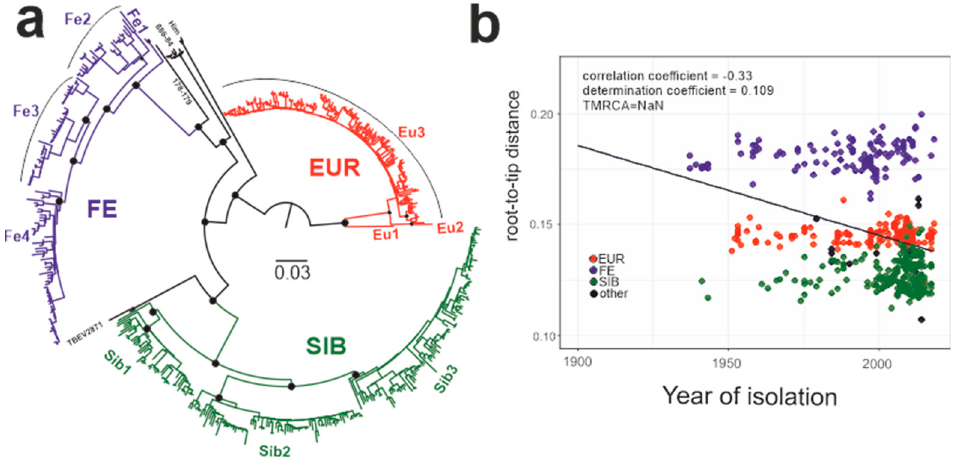
Figure 3. ( a ) Maximum likelihood tree for TBEV species (1028 nt). Black circles indicate high-level nodes that were supported by UFBoot values over 95% [45]. ( b ) Association between root-to-tip distance and time of isolation for the whole TBEV species. Viruses 2020 , 12 , x FOR PEER REVIEW